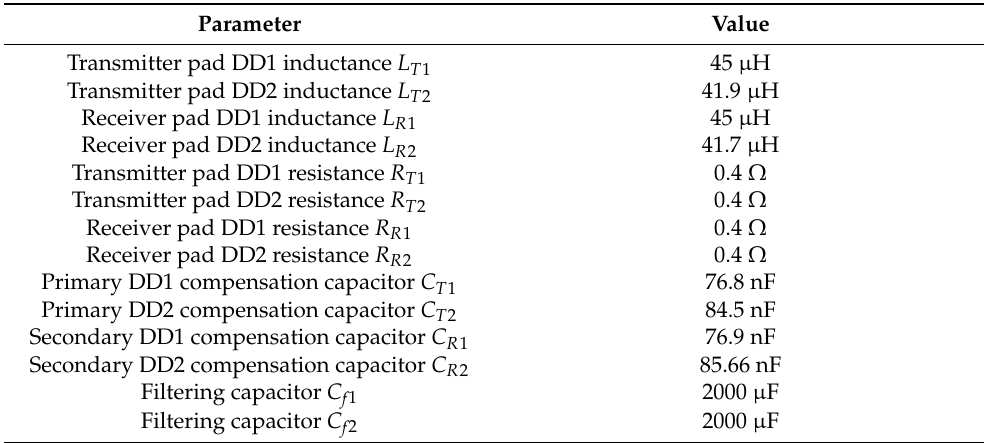
Table 1. Double DD coil IPT systems‘